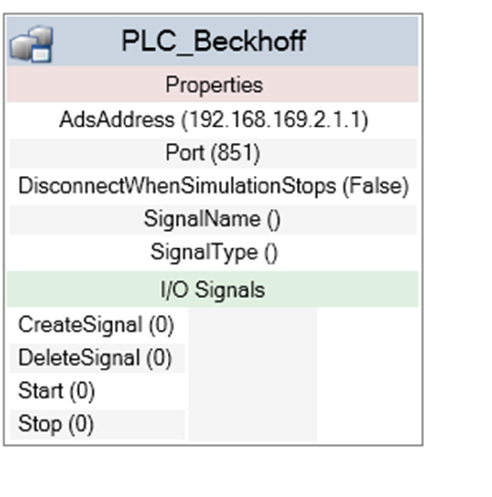
Algorithm 1 Communication initialization